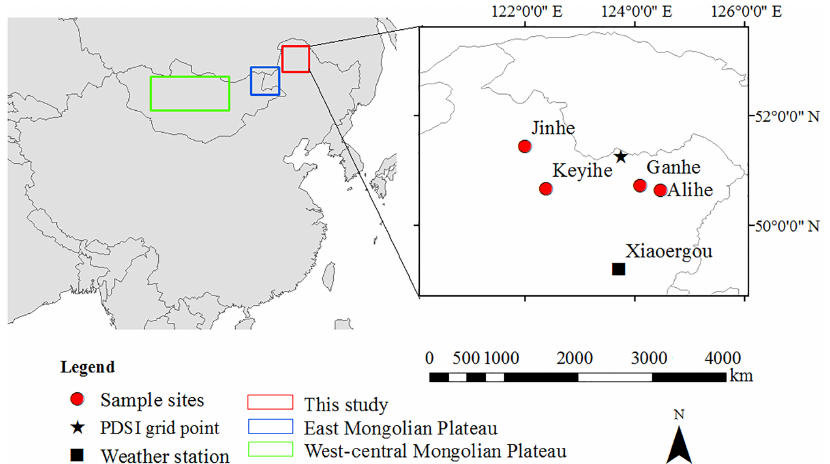
Figure 1. Sampling sites and weather station distribution map. The red circles, star and black square are the sampled sites, Palmer drought severity index (PDSI) grid point and the weather station, respectively. The red box represents the northern Daxing’an Mountains (this study). The blue and green boxes represent the east and west-central Mongolian Plateau,